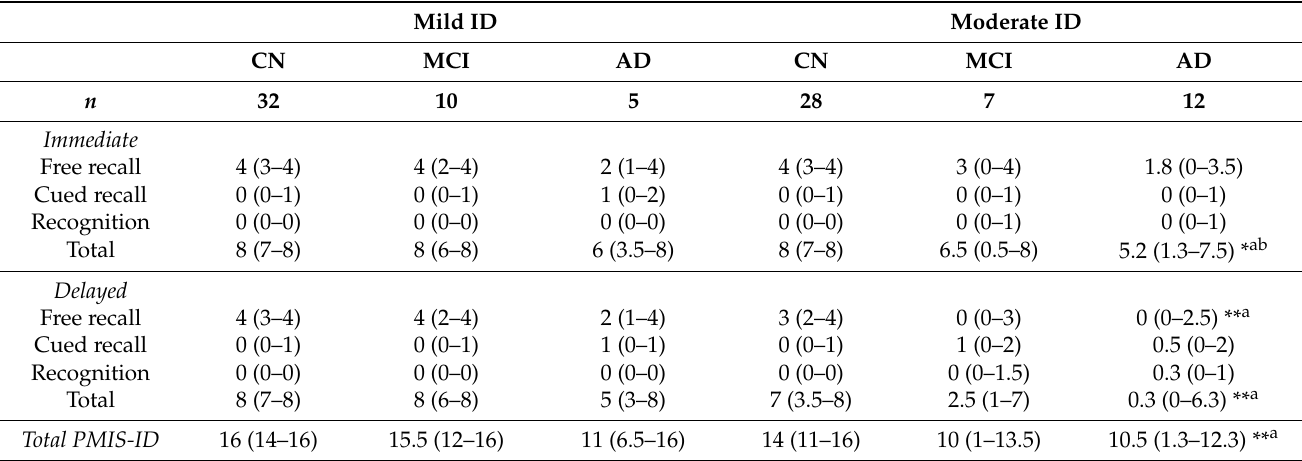
Table 5. PMIS-ID descriptive scores by group and level of intellectual